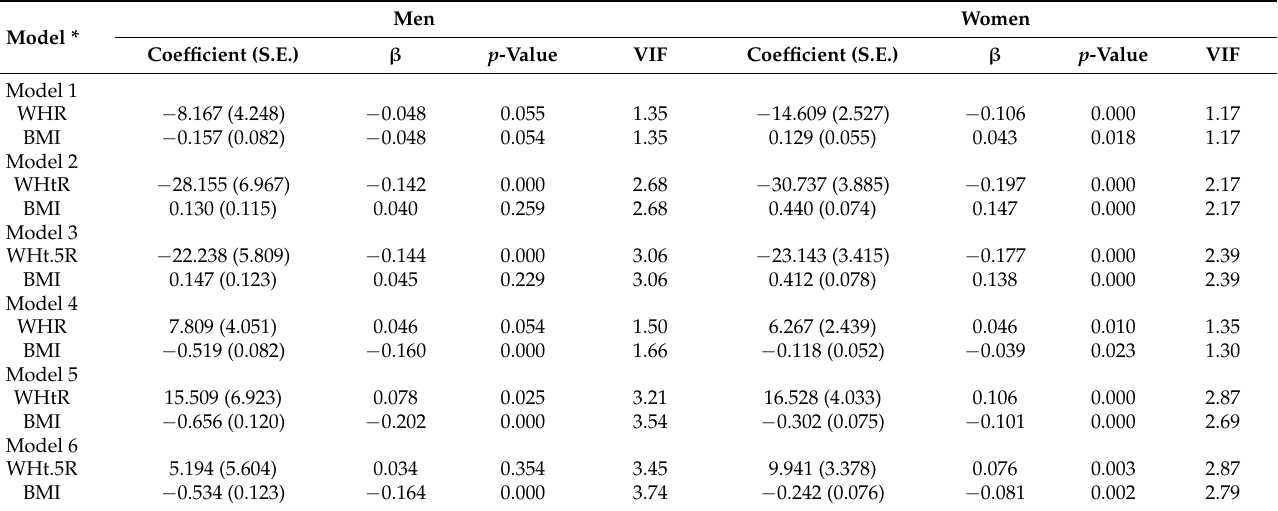
Table 2. Multiple linear regression of estimated glomerular filtration rates and waist circumference- related obesity metrics, compared with the body mass